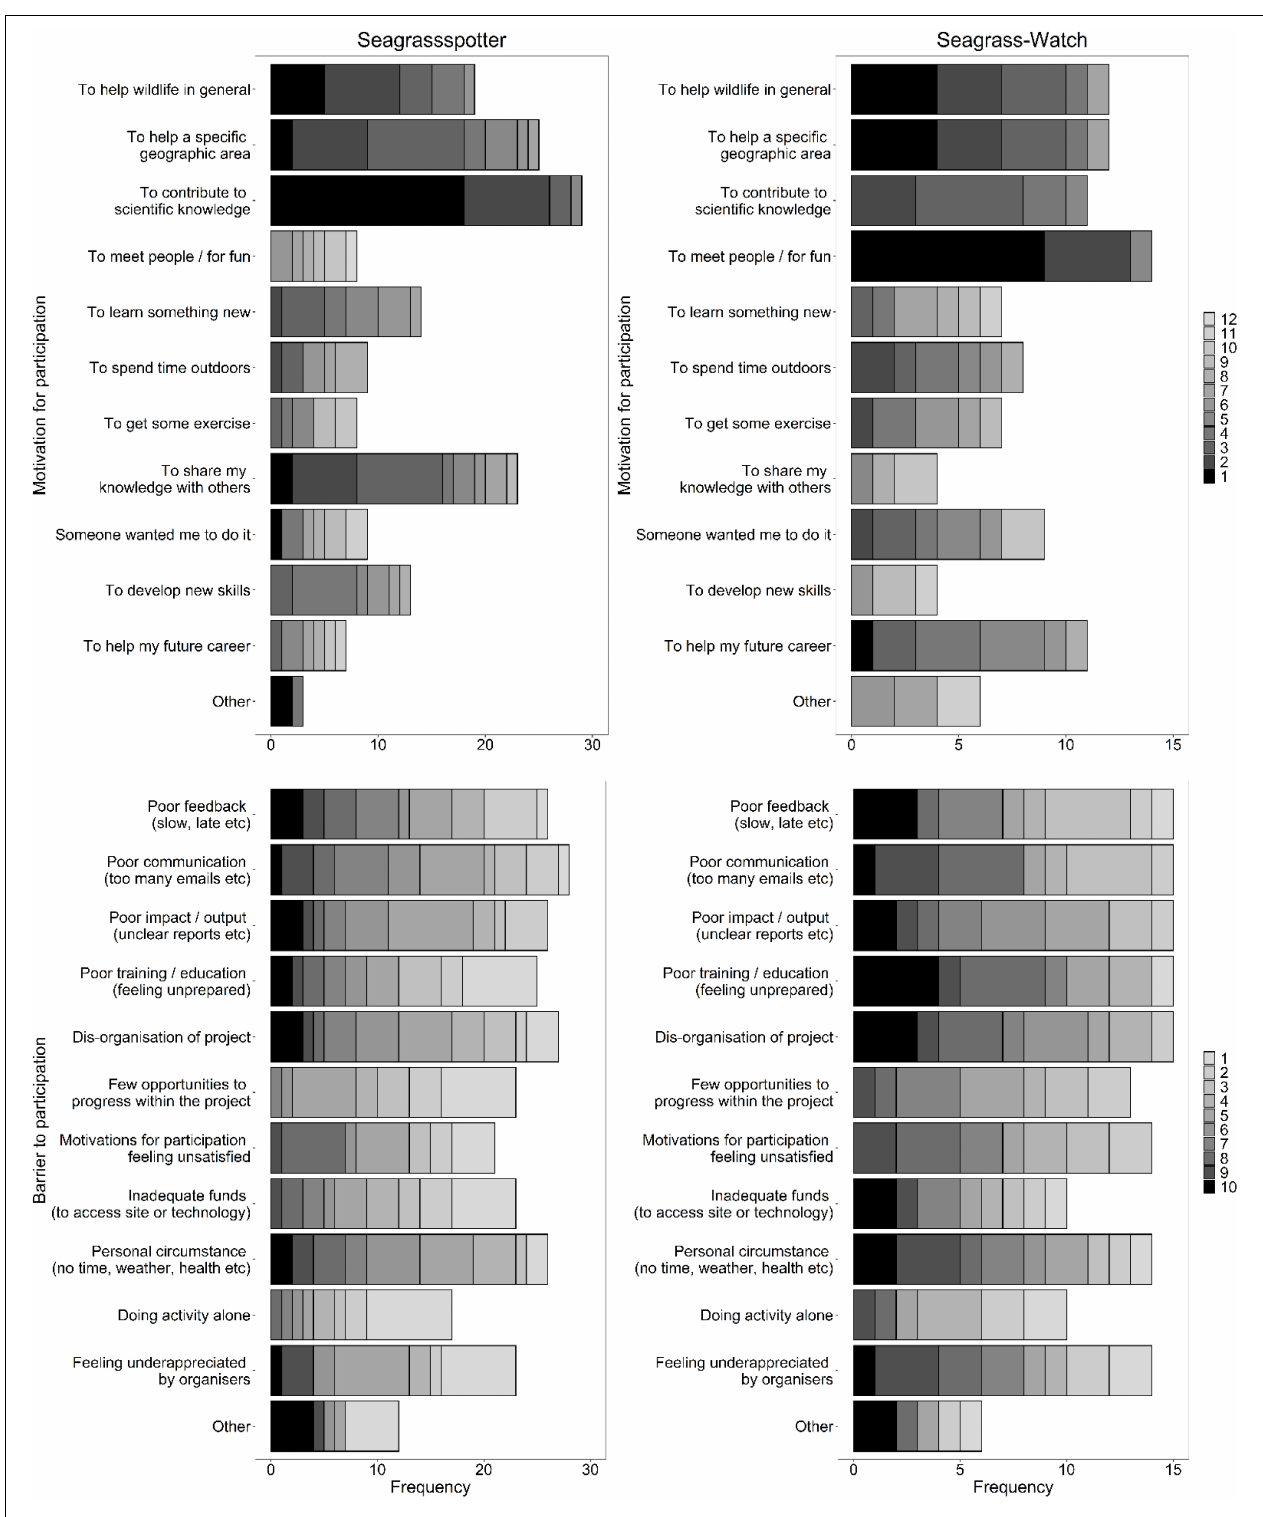
FIGURE 1 | Frequencies of motivations (upper) and barriers (lower) to participation in SeagrassSpotter (left) and Seagrass-Watch (right) . Colour gradient indicative of the level of motivation/deterrence where darker colours represent higher scoring in ranking or Likert type questions. Note the change in key for upper (1 = most motivating and 12 = least motivating) and lower (10 = most deterring and 1 = least deterring) plots.